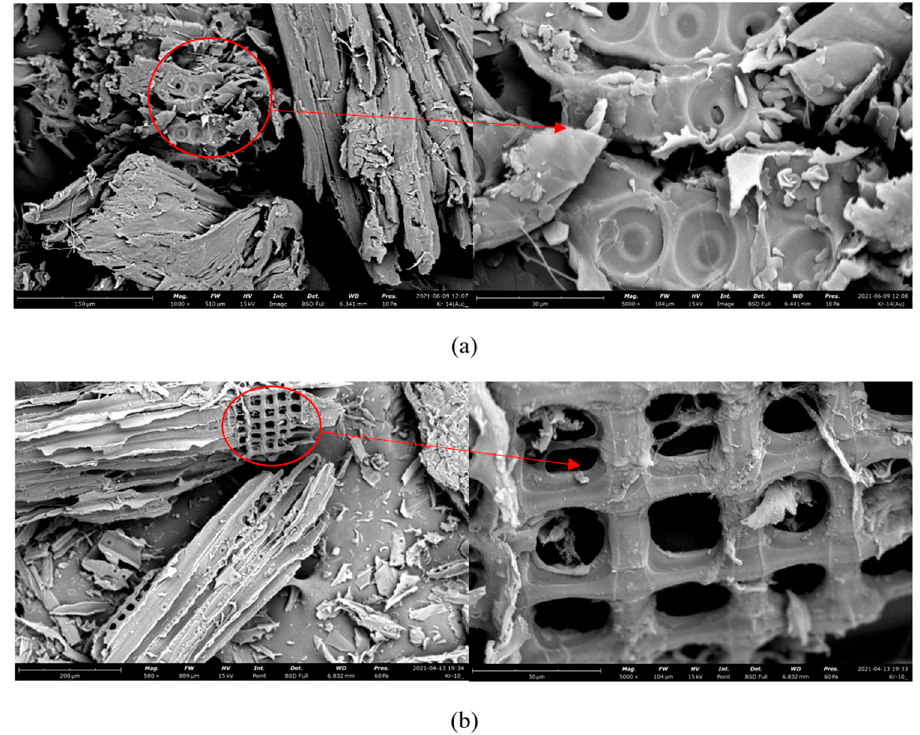
Figure 2. Micrographs of initial sawdust ( a ) and biochar ( b ) obtained by hydrothermal